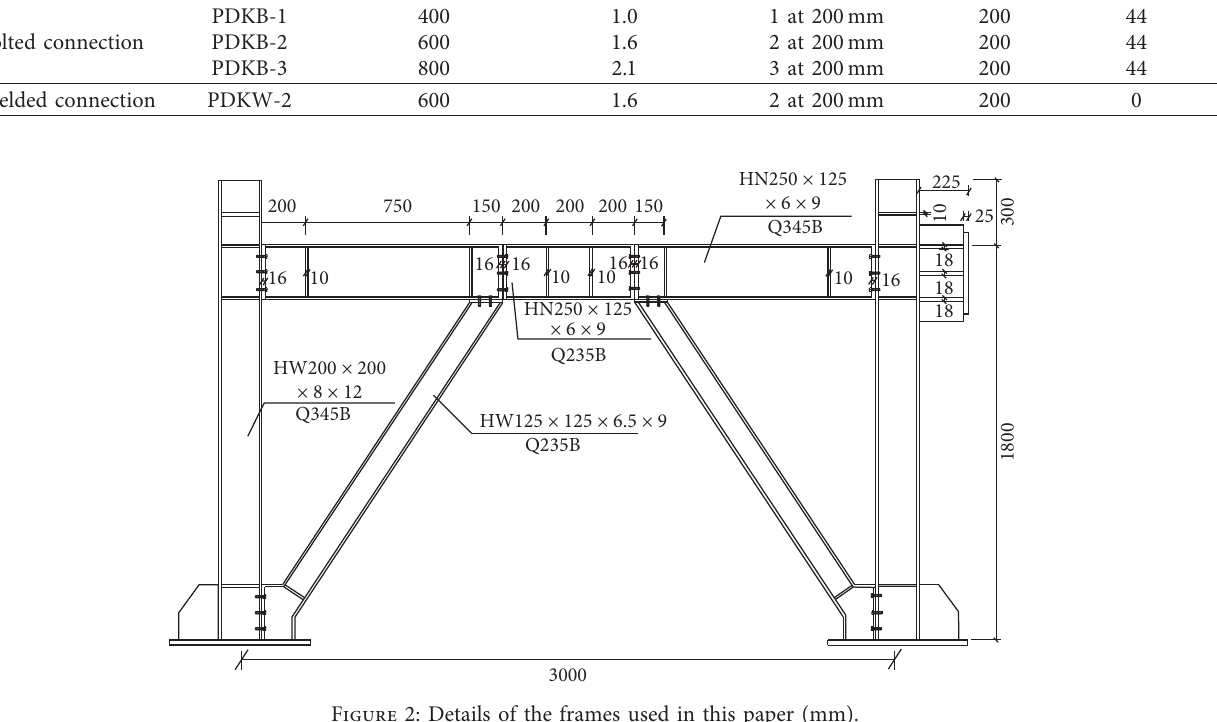
Figure 2: Details of the frames used in this paper